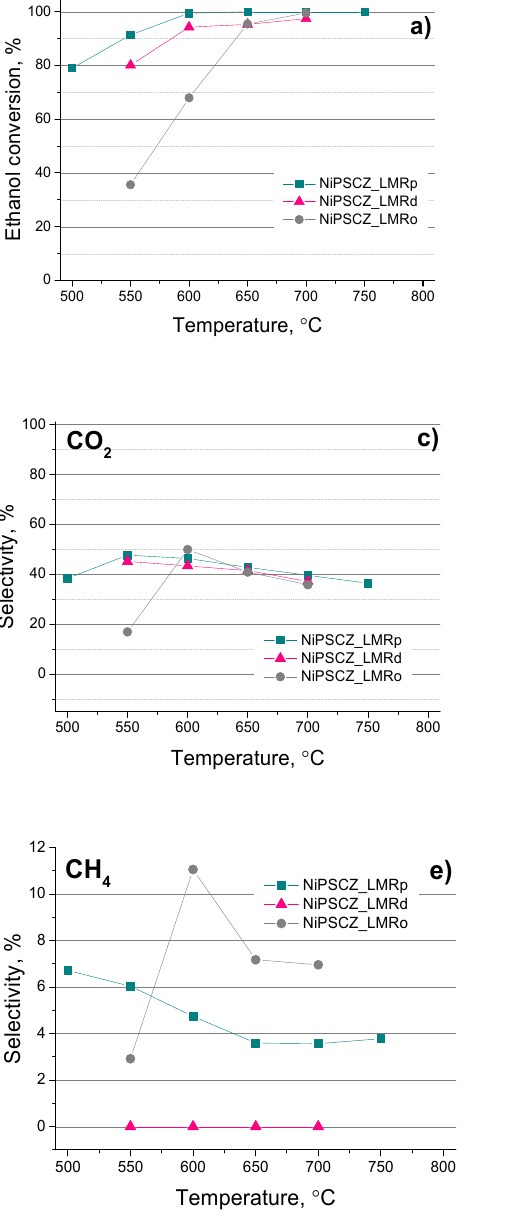
Figure 3. Temperature dependencies of ( a ) ethanol conversion; ( b ) hydrogen yield; selectivities of ( c ) CO 2 ; ( d ) CO; ( e ) CH 4 ; and ( f ) H 2 /CO ratio for NiPSCZ_LMRp, NiPSCZ_LMRd and NiPSCZ_LMRo in ethanol steam reforming reaction.